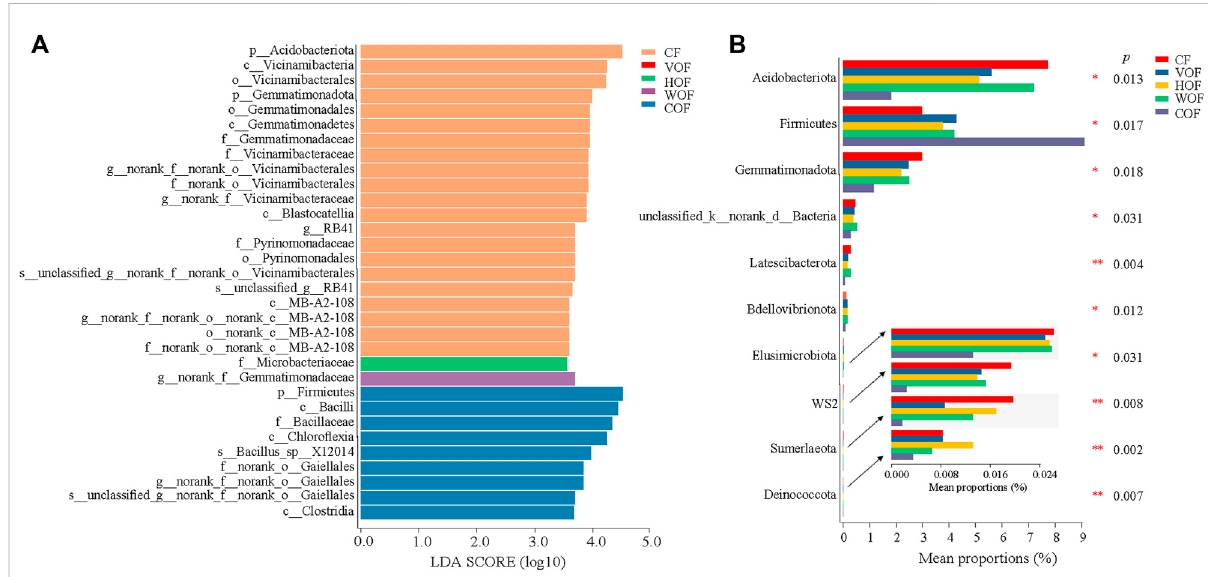
FIGURE 6 LEfSe (A) andcomparativeanalyses (B) ofbacterialcommunityatthephylumlevelintherhizospheresoilbasedontheKruskal – WallisHtest.CF, VOF,HOF, WOF,andCOF represent thetreatments oftobacco-specialchemicalfertilizer, vermicompost-based, humicacid-based,woodbiochar- based, and compound functional organic fertilizers, respectively. Only the top 10 bacteria that showed a signi fi cant difference ( p < 0.05) among the fi ve treatments are